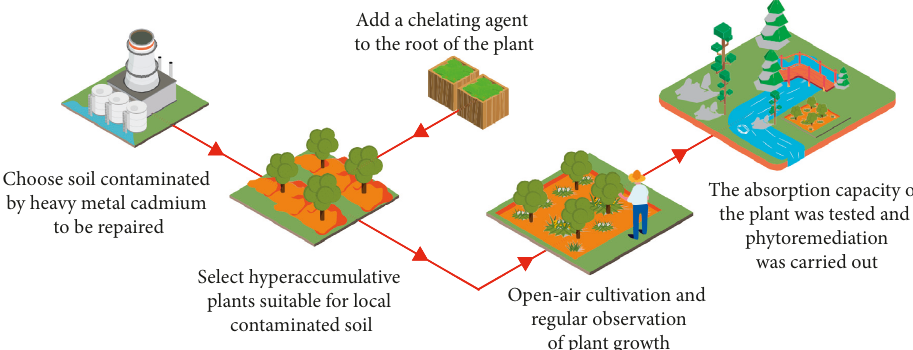
Figure 1: Chemical characteristics of soil heavy metal elements caused by fertilization by